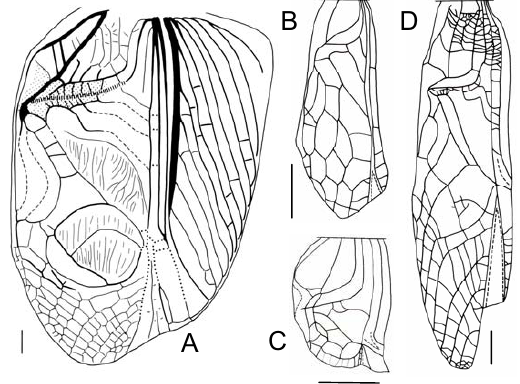
Fig. 2 – Morphological diversity of cricket stridulatory appara- tus. Venationof Grylluscampestris (A)(modifiedfromDesutter- Grandcolas1995b), Nisitrusvittatus (B), Agnotecousyahoue (C), and Cardiodactylus canotus (D). Scale bar: 1